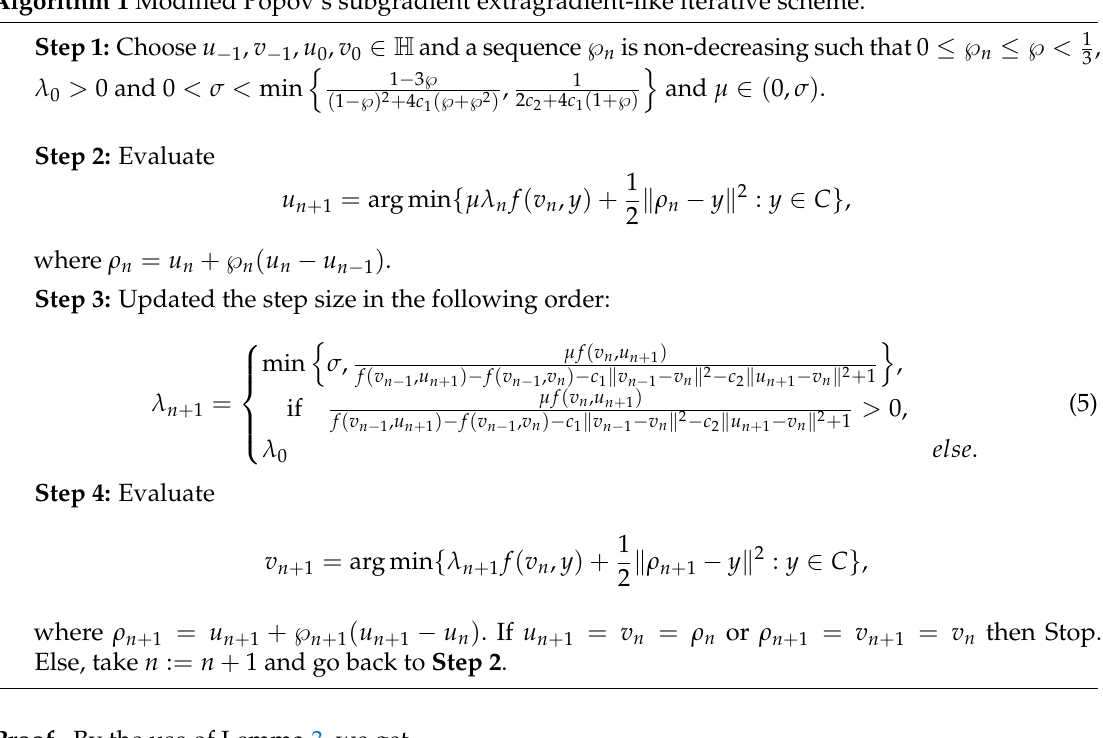
Algorithm 1 Modified Popov’s subgradient extragradient-like iterative